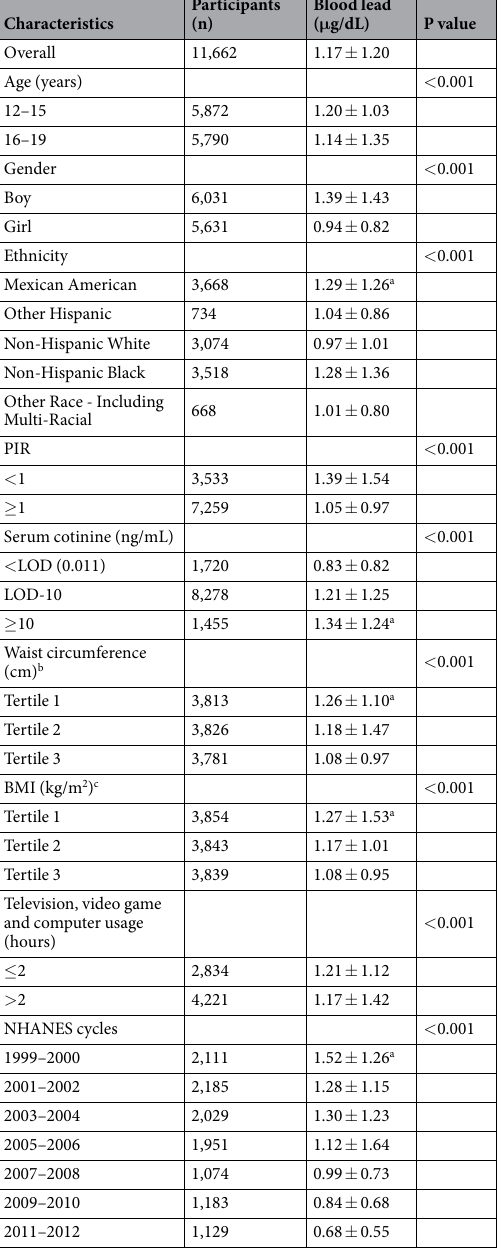
Table 1. Blood lead concentration (mean ± SD) for participants according to demographic. a Significant higher than other group by post hoc multiple comparisons. b Mean values ± SD: 81.7 ± 14.9 cm. Tertile ranges (cm): tertile 1, 47.1–73.3; tertile 2, 73.4–84.4; tertile 3, 84.5–179.0. c Mean values ± SD: 24.0 ± 6.0 kg/m 2 . Tertile ranges (kg/m 2 ): tertile 1, 13.1–20.7; tertile 2, 20.8–24.9; tertile 3, 25.0–66.3. PIR: poverty income ratio, LOD: limit of